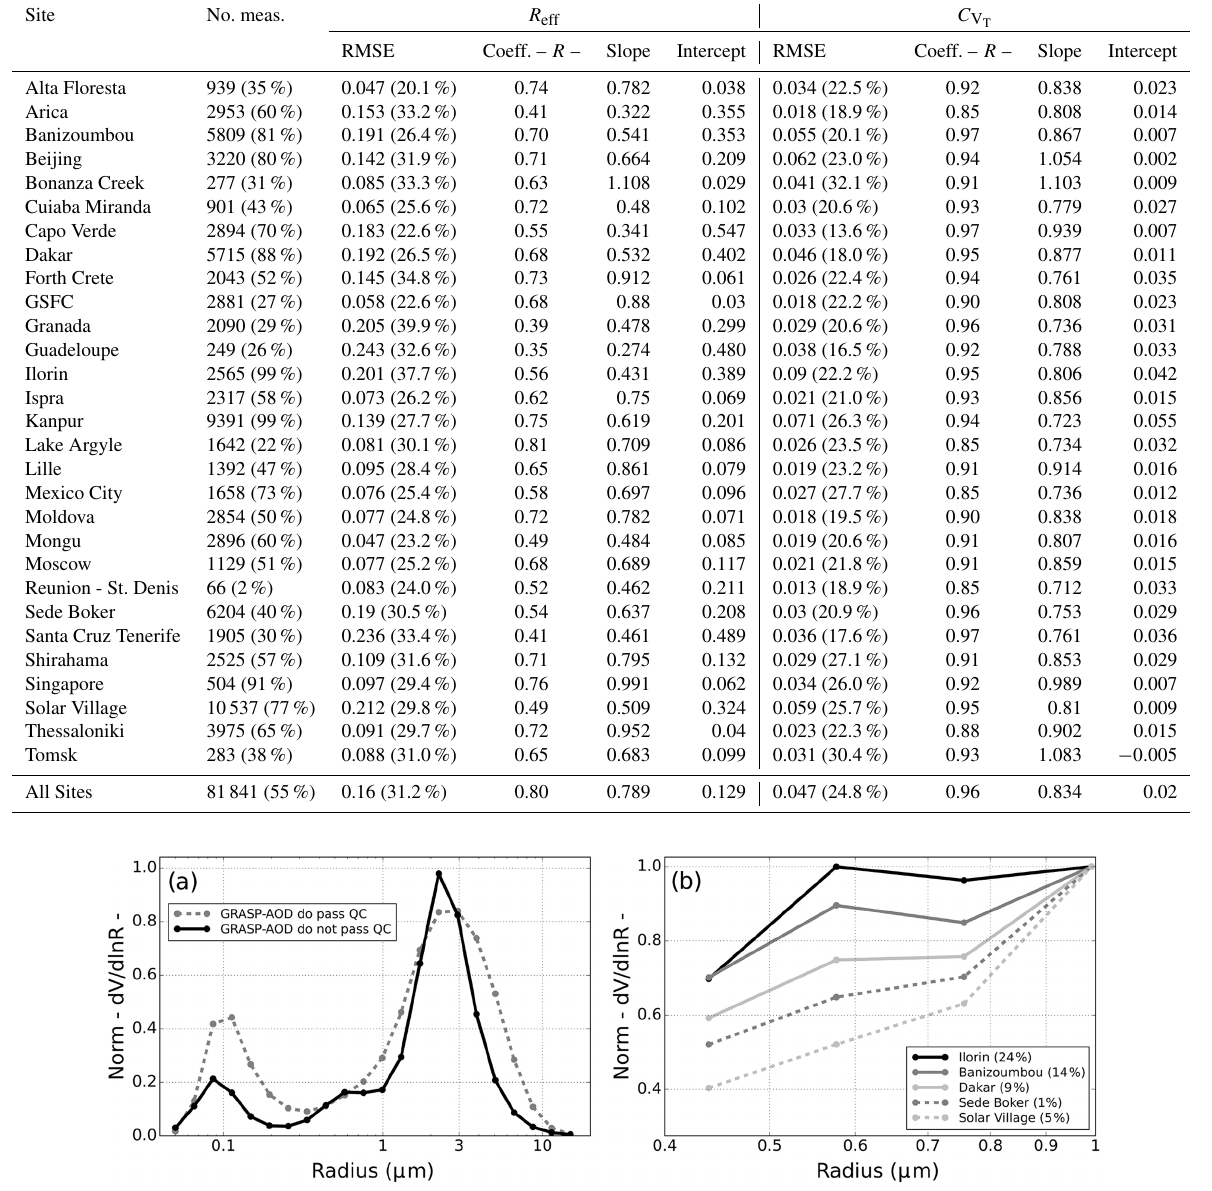
Figure 11. (a) Average of normalized (by maximum value) size distributions retrieved by the AERONET aerosol algorithm at the Ilorin site. They have been divided into two groups depending on whether the coincident GRASP-AOD retrievals meet the quality criteria defined in Sect. 2.2: gray dashed line when the coincident GRASP-AOD retrievals pass the quality criteria (2594 inversions) and black solid line for the cases when the coincident GRASP-AOD retrievals do not pass the quality criteria (1014 inversions). (b) Averages of normalized (by the value at 0.992µm) size distributions at several AERONET sites when the coincident GRASP-AOD retrievals do not meet the quality criteria: Ilorin (black solid line), Banizoumbou (gray solid line), Dakar (silver solid line), Sede Boker (gray dashed line) and Solar Village (silver dashed line). Only the interval with radii from 0.439 to 0.992µm is